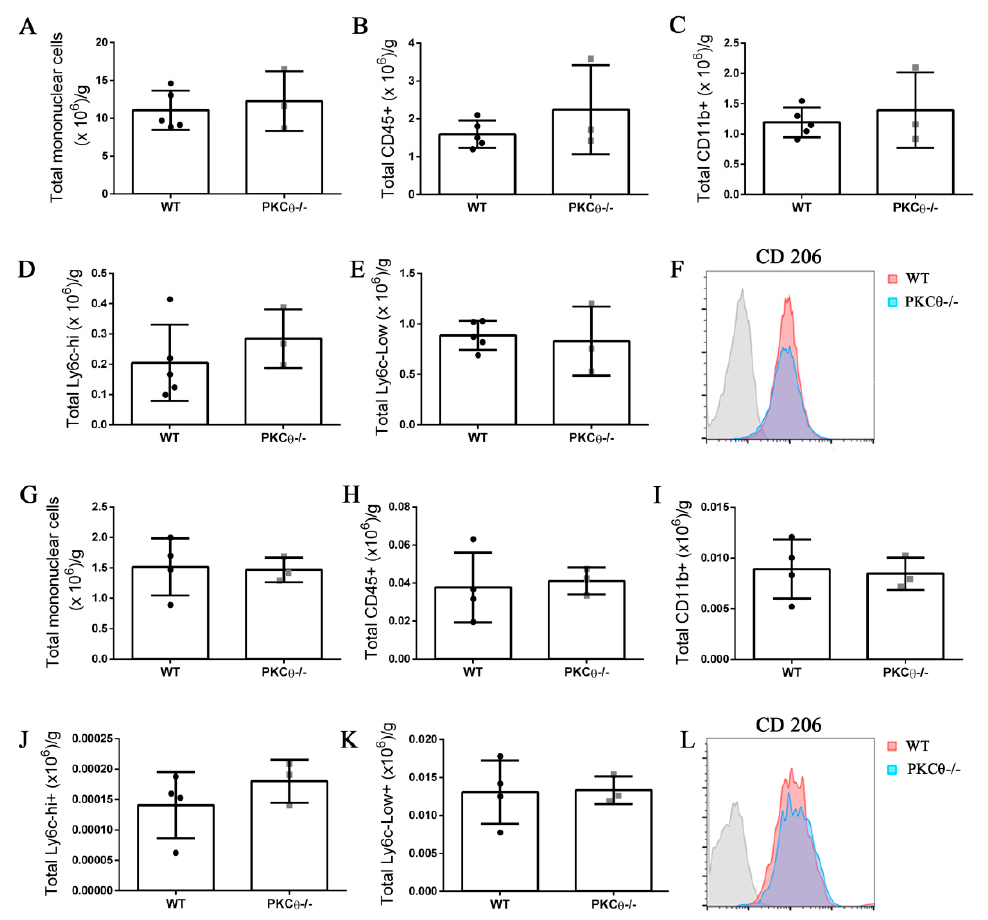
Figure 7. Knock-out of PKC θ does not alter the inflammatory milieu after induction of acute injury. ( A ): Total number of mononuclear cells, ( B ): CD45 + cells, ( C ): CD11b + cells, ( D ): Ly6c-hi + cells, and ( E ): Ly6c-low + cells, normalized on muscle mass 3 days after CTX injury in WT and PKC θ - / - GA. ( F ): histogram showing CD206 mean fluorescence in WT and PKC θ - / - GA 3d after CTX. ( G ): Total number of mononuclear cells, ( H ): CD45 + cells, ( I ): CD11b + cells, ( J ): Ly6c-hi + cells, and ( K ): Ly6c-low + cells, normalized on muscle mass 10 days after CTX injury in WT and PKC θ - / - GA. ( L ): histogram showing CD206 mean fluorescence in WT and PKC θ - / - GA 10d after CTX. Error bars represent mean ± sem.